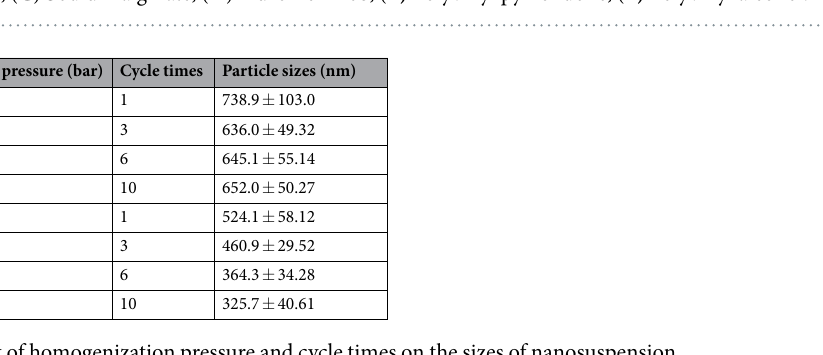
Table 1. Effect of homogenization pressure and cycle times on the sizes of